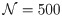
Cell colonies in a square grid under complex illumination in the stochastic switching case.Configurations of a number of cell colonies, arranged in a square grid, illuminated by two different light sources placed at N and E. This arrangement of light sources creates a gradient in intensity. Cells stochastically switch between biasing their motion towards one of the two light sources, with the effective intensity of the light sources towards N and E represented by p1 and p2 respectively. The map of p1 and p2 across a 5 × 5 grid is represented in (a) and (b) respectively. The morphology of colonies placed on this 5 × 5 grid is shown in (c). Each colony contains N=500 cells, and the model was simulated for 4 × 104 time steps.